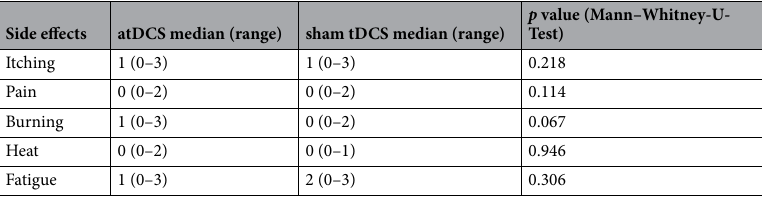
Table 4. Severity ratings of experienced side effects after the last experimental